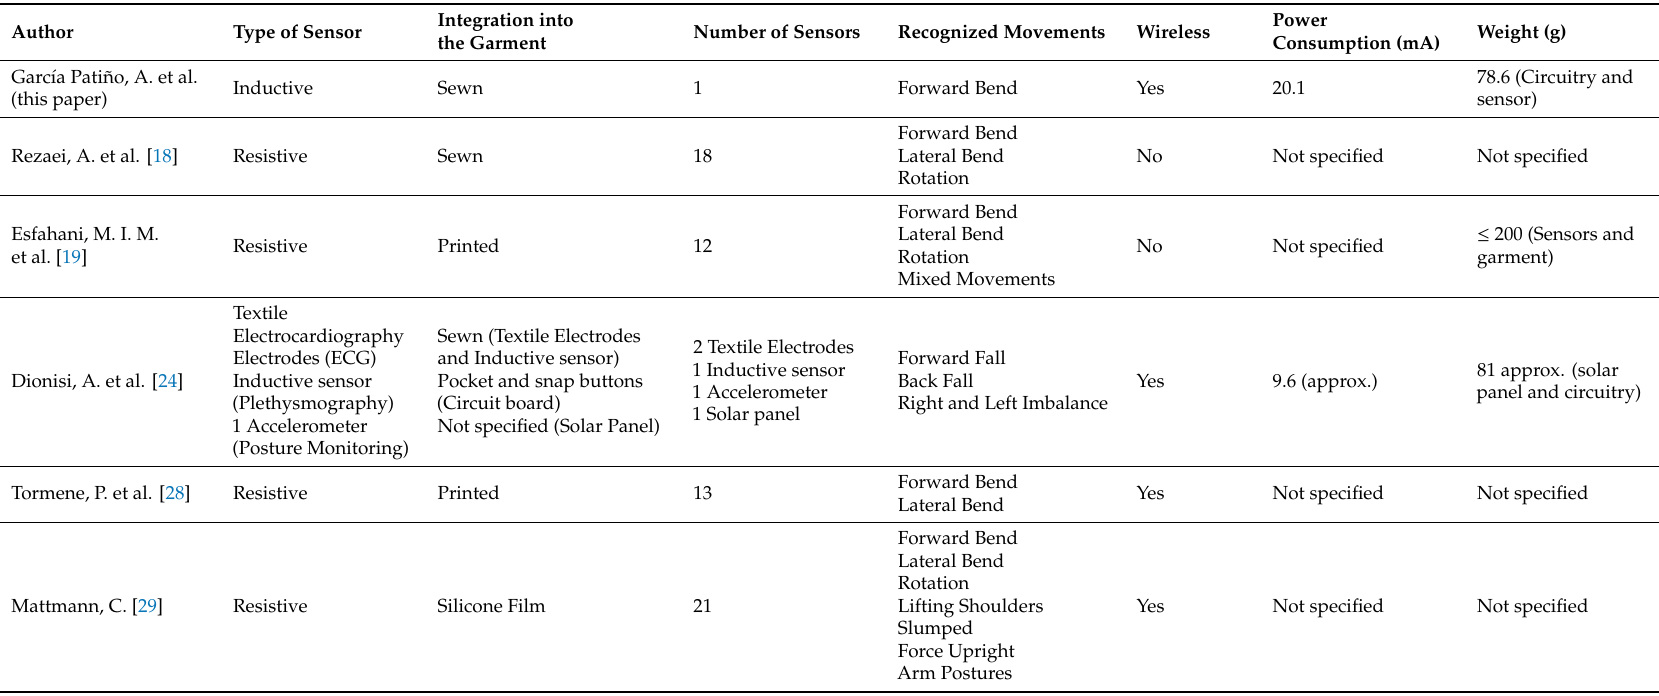
Table 3. Comparison of the present prototype against others in the